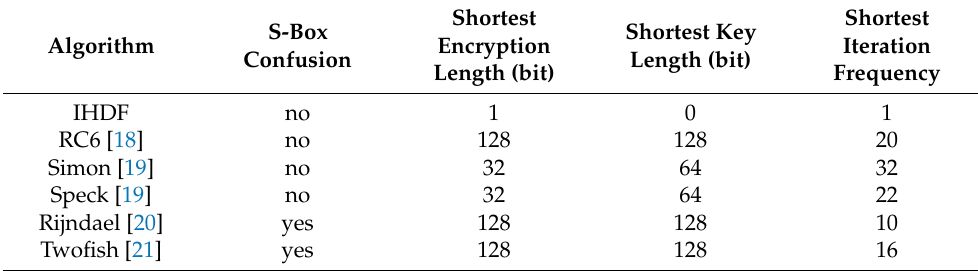
Table 2. The computational complexity of different